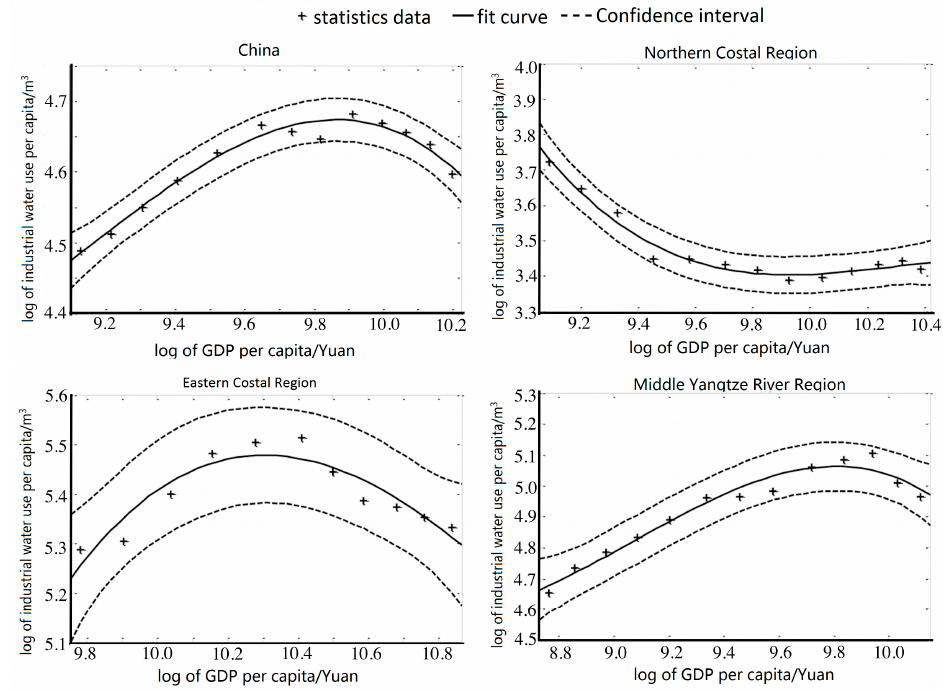
Figure 3. Estimated EKC curve of China, northern coastal, eastern coastal, and middle Yangtze River regions (corrected).